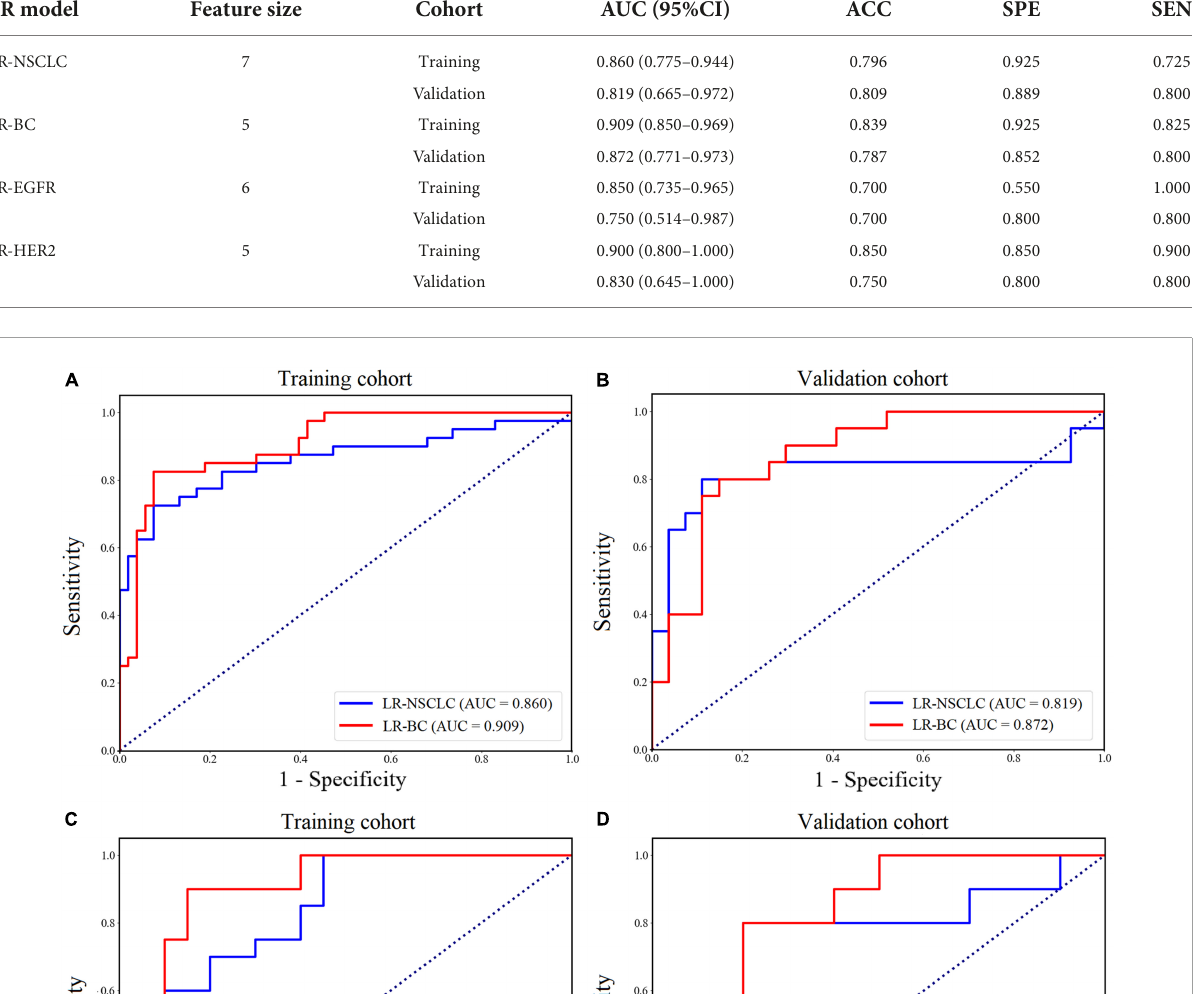
GAP is to avoid overfitting at this layer, and thus improving generalization abilities of the network. Another advantage is maps and